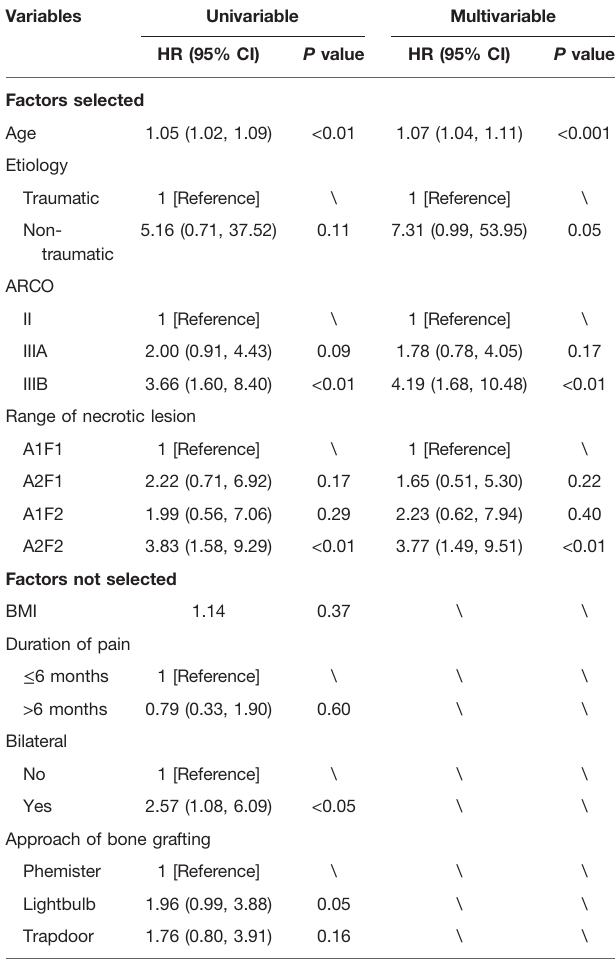
TABLE 3 | Cox proportional hazards regression model showing the correlation of factors with